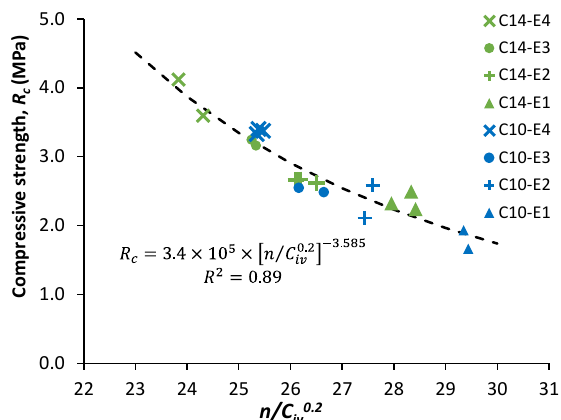
Figure 11. Effect of modified ratio of porosity to volumetric cement content on unconfined compres- sive strength.